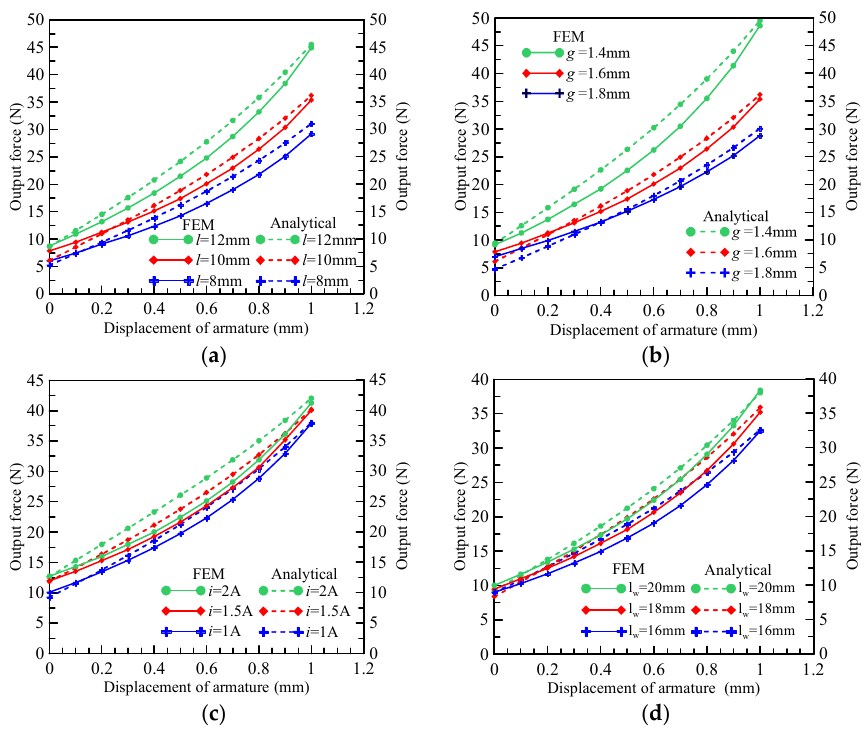
Figure 14. The parametric design via both analytical modeling and FEM simulation. ( a ) The influence of l on force-displacement characteristics. ( b ) The influence of g on force-displacement characteristics. ( c ) The influence of i on force-displacement characteristics. ( d ) The influence of l w on force-displacement characteristics.